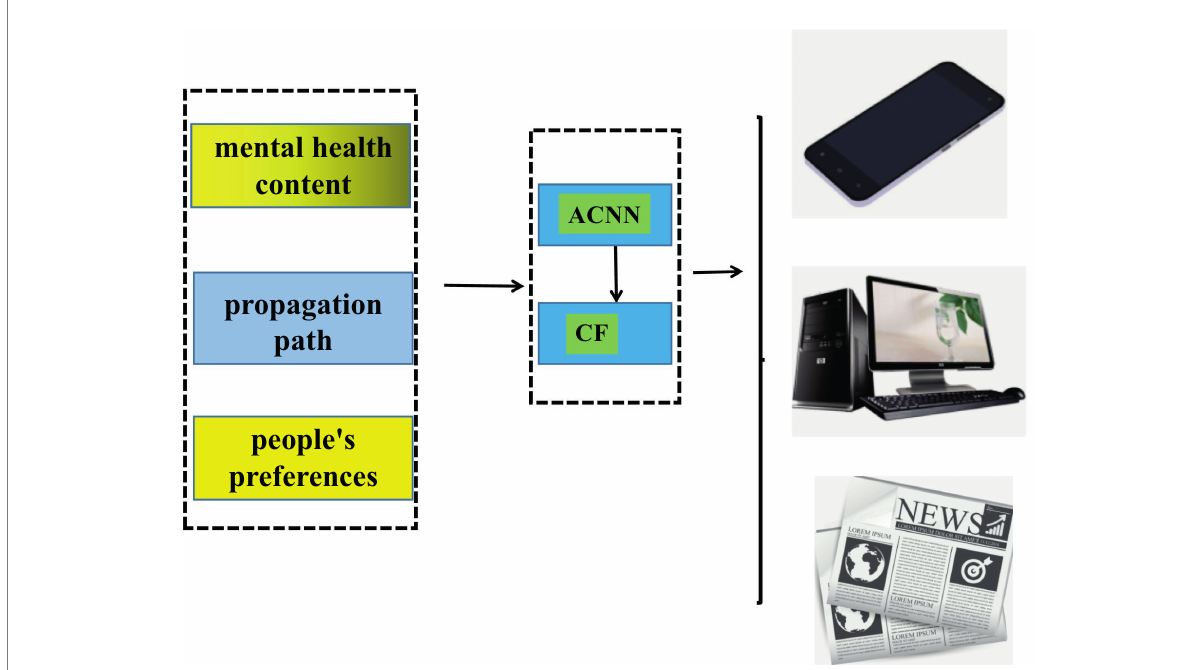
FIGURE 1 Design of communication programs for mental health literature through ACNN and new media